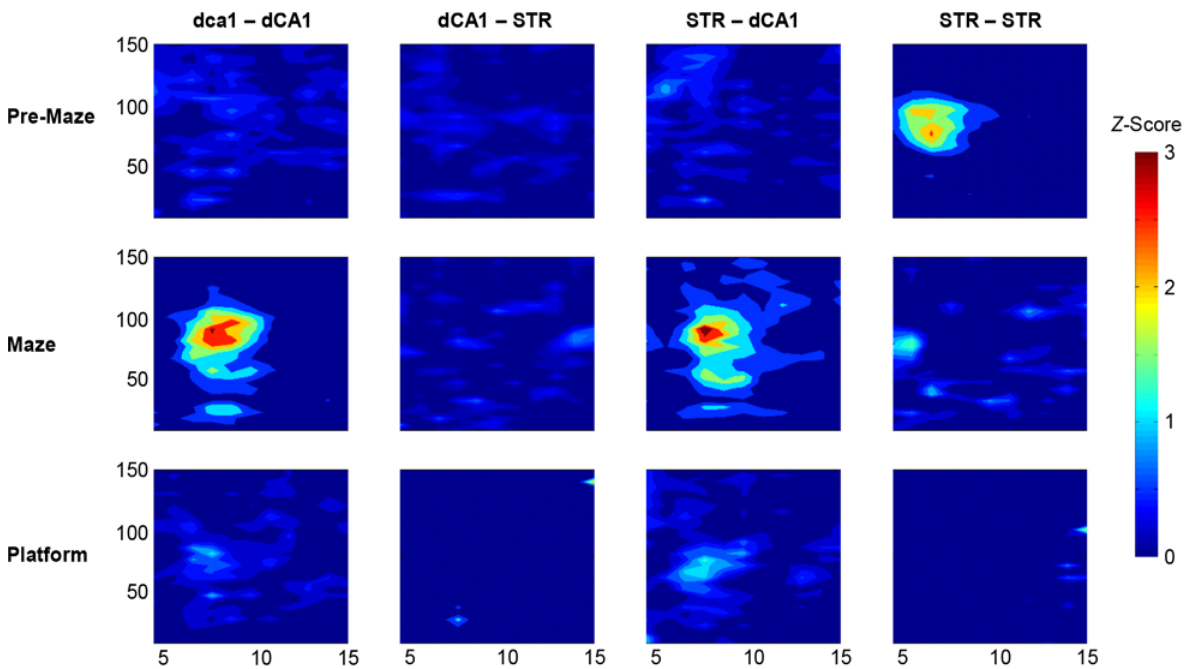
Fig 7. Cross-frequency modulation at different task phases. Montage depicting the theta-gamma cross-frequency modulation between and within the dCA1 and striatal (STR) brain regions, for each of the three task phases (pre-maze, maze and platform). The y-axis represents the modulated gamma frequency, whereas the x-axis is the modulating theta frequency. MI values are represented as a z -score following statistical comparisons with shuffled data. Notably, cross-frequency modulation is at its strongest for dCA1 gamma, for rats inside the maze. Intra-striatal cross-frequency modulation is also at its strongest when the rat is not engaged in the water-maze task (Pre-Maze; STR-STR).